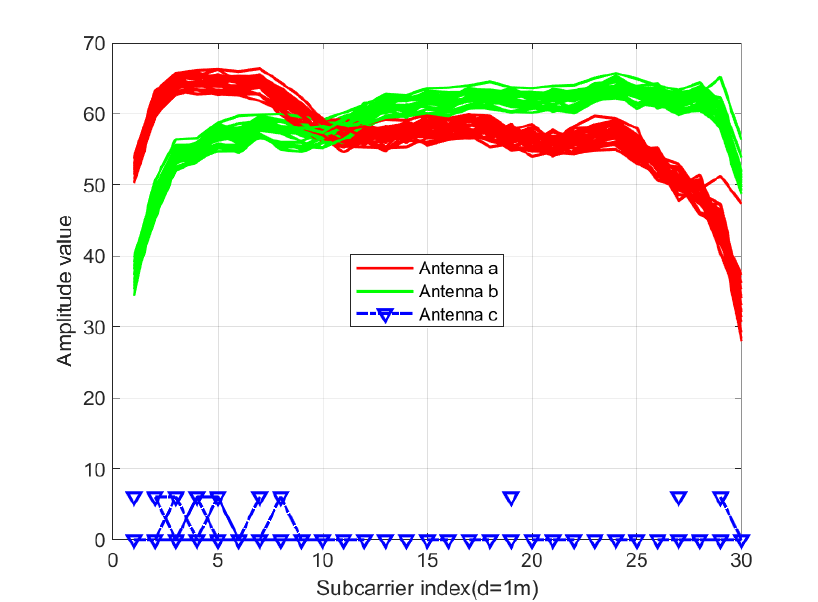
Figure 3. The amplitude frequency response of channel frequency response (CFR) under three receiving